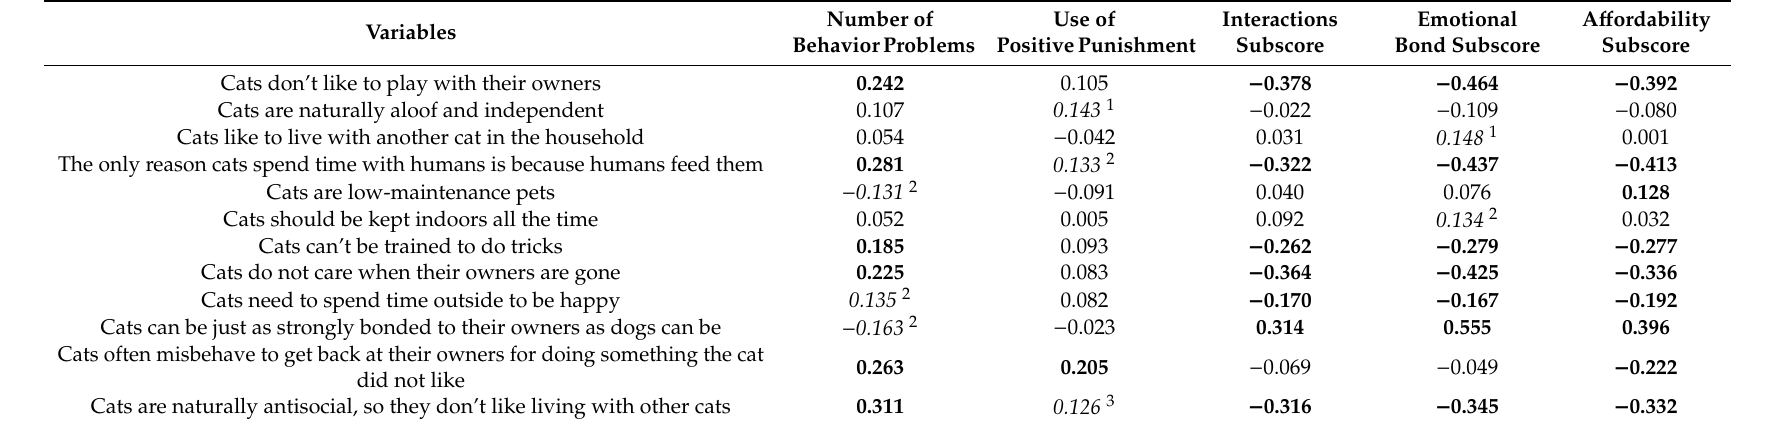
Table 7. Correlations between owner attitudes (higher score reflects stronger agreement with the statement), number of behavior problems reported by owner, use of positive punishment-based responses to perceived misbehavior (higher score indicates more punishment used) and three bond-related measures: interactions (between owner and cat), emotional bond, and a ff ordability (higher score reflects a more positive relationship with the cat, e.g., a lower ‘a ff ordability’ score meant that the owner was more bothered by the costs associated with caring for their cat). Coe ffi cients shown in bold font indicates that the correlation is significant from 0 at p < 0.0001; italic font indicates that the correlation is significant but at a di ff erent level; see footnotes for these p